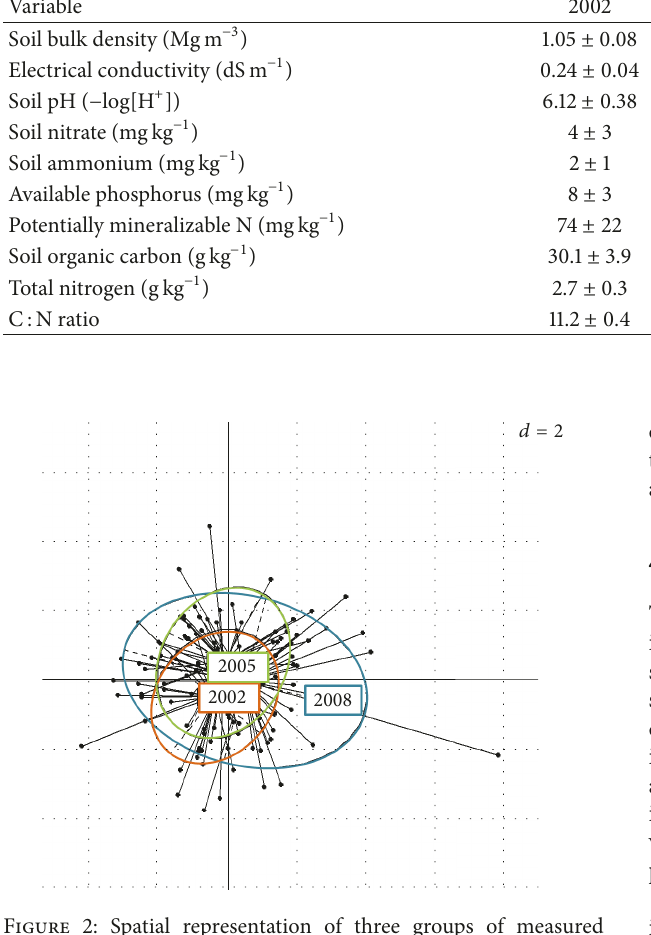
Figure 2: Spatial representation of three groups of measured variables based on sampling year (2002, 2005, and